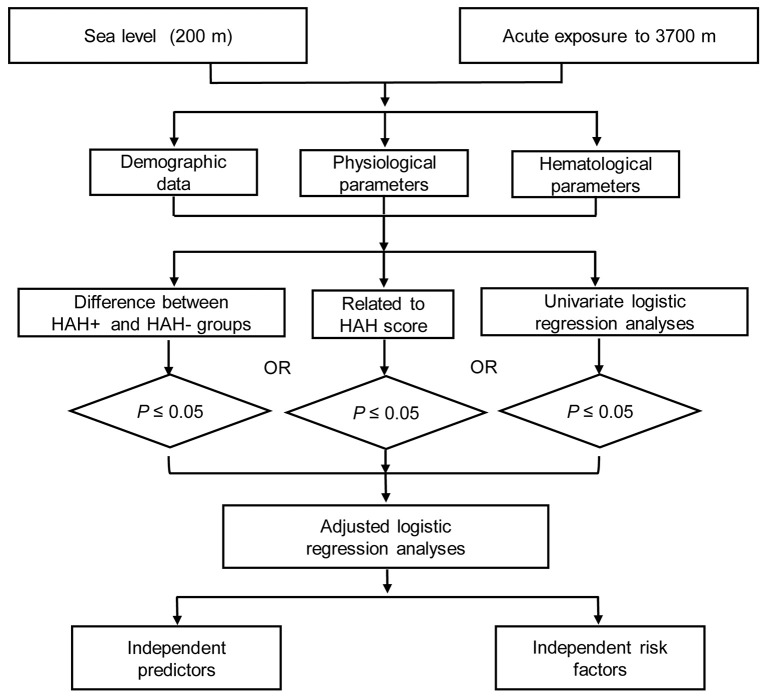
The flow diagram of this study. HAH+, participants with high-altitude headache (HAH); HAH−, participants without HAH.